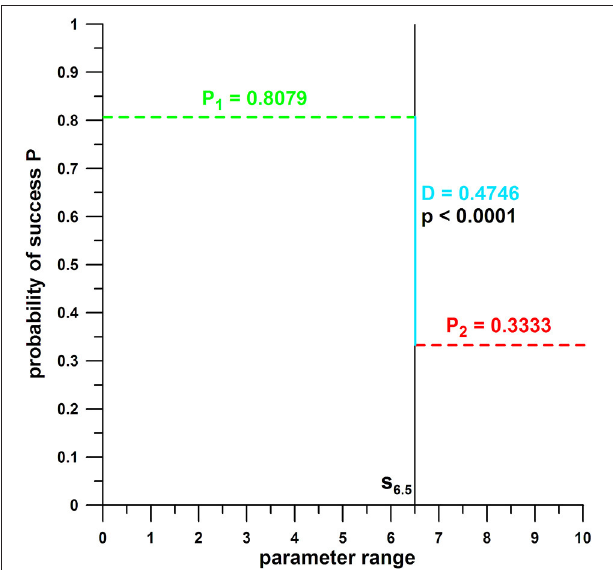
FIGURE 4 | Principle of probability of success (P) against the range of parameter data; the black vertical line s divides the parameter range into two subsamples (smaller and greater than s ); P 1 = average of hit and miss data for the parameter range smaller than the threshold value s (s = 6.5); P 2 = average of hit and miss data for the parameter range larger than the threshold value s ; D = probability differential (P 1 – P 2 ); P 1 and P 2 are significantly different ( p = p -value); the parameter range associated with P 1 , the larger of the two P , is the favorable range of the parameter tested; the parameter range associated with P 2 , the smaller of the two P s, is the un favorable range of the parameter tested.